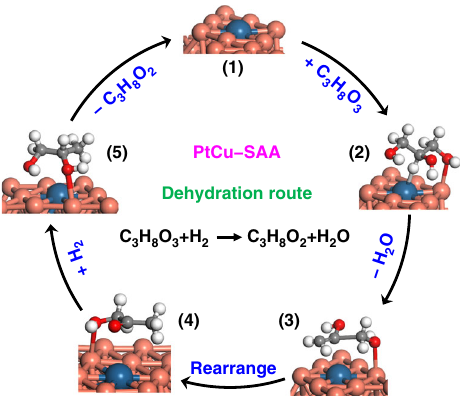
Fig. 9 Schematic representation for the reaction mechanism. Schematic illustration for the reaction mechanism of glycerol hydrogenolysis to 1,2- PDO on the surface of PtCu – SAA